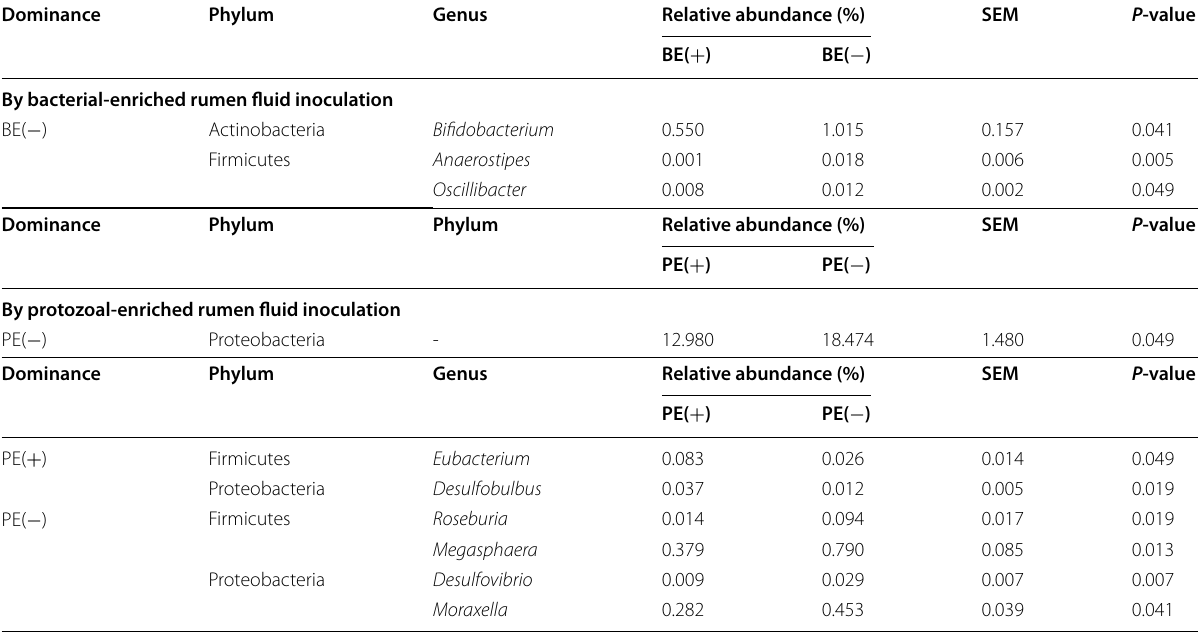
Only the taxa which have over 0.01% average relative abundance in at least one of the treatments [BE( BE, bacterial-enriched rumen fluid; PE, protozoal-enriched rumen